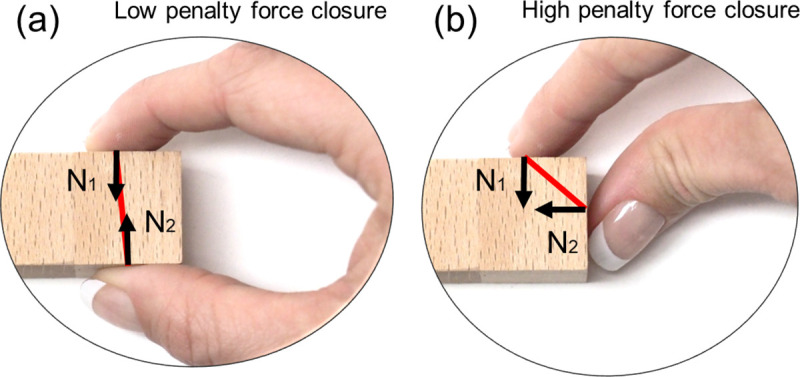
Force closure.Examples of grasps with (a) low penalty and (b) high penalty force closure.